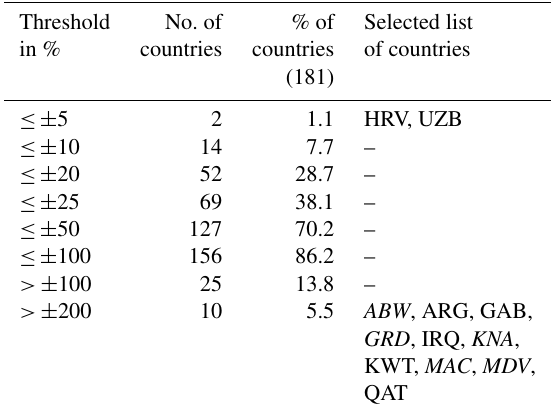
Table 3. Changes in 5-year running-mean conversion factors be- tween the country-specific base year and 2005 for all 181 countries that have sufficient overlapping years of data. Where informative the specific countries are listed with their respective ISO3 codes; italicized countries lack individual country resolution in the